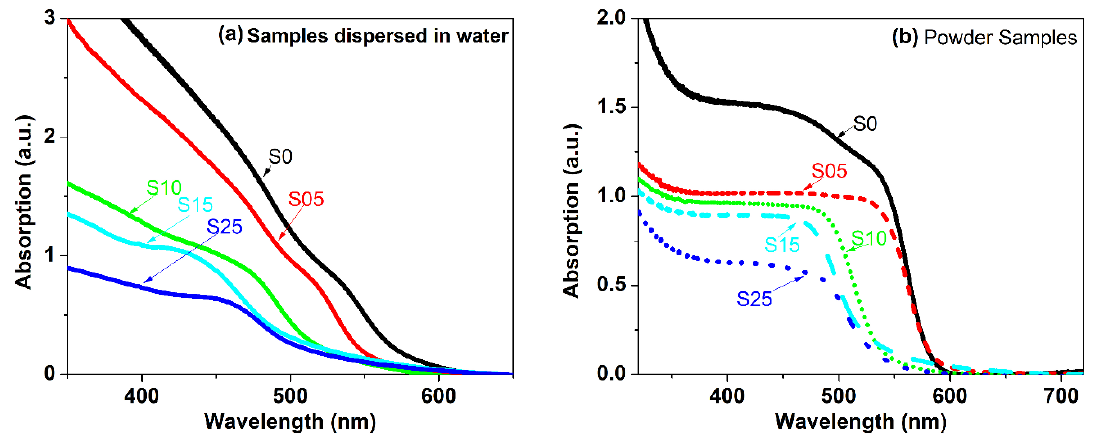
Figure 11. Absorption of CdSe (1 − x ) S x with different concentrations of S of the precipitated samples ( a ) as a suspension in water ( b ) in a powder form.